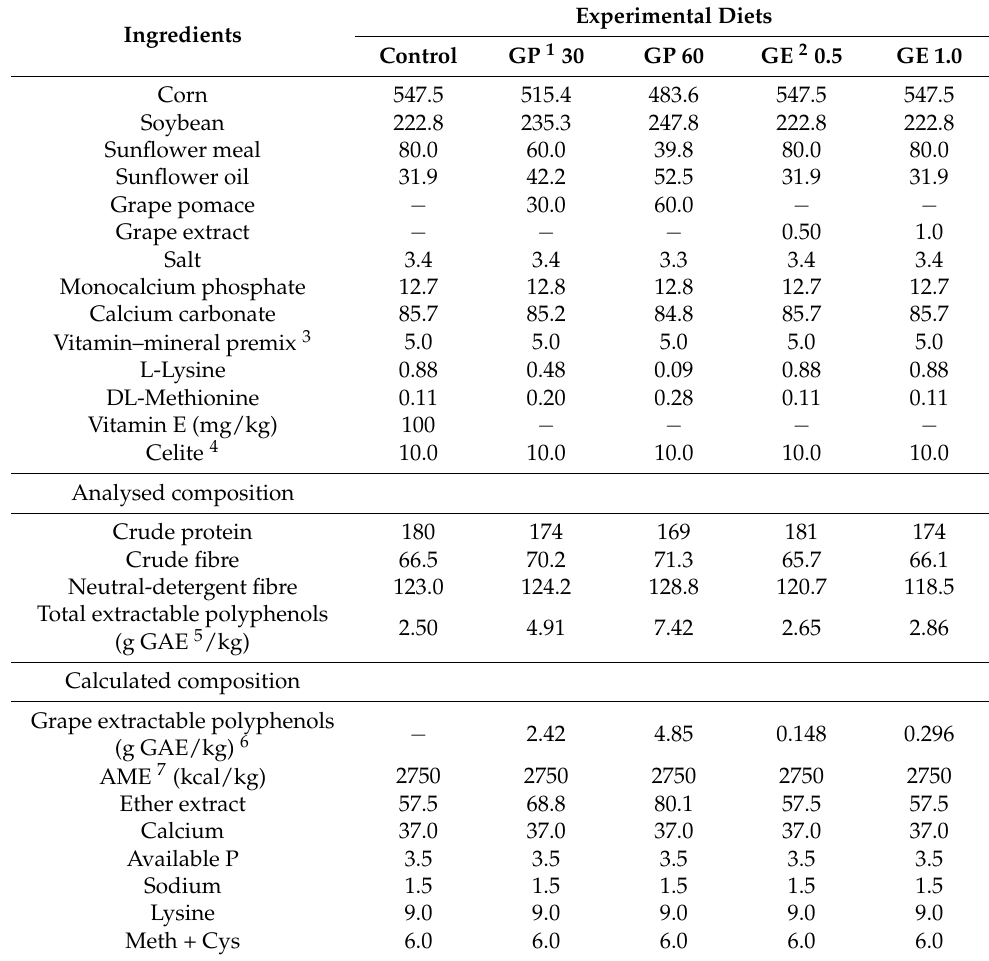
Table 2. Ingredients and nutrient composition of experimental diets (g/kg as